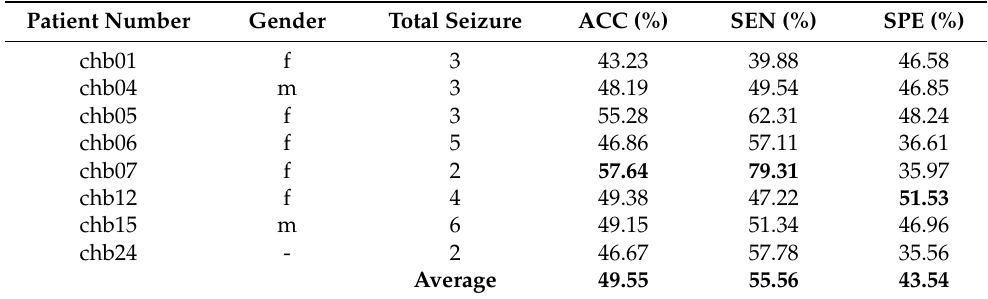
Table 3. LOO validation method’s results on the CHB-MIT data set. Bold format highlights maximum values.